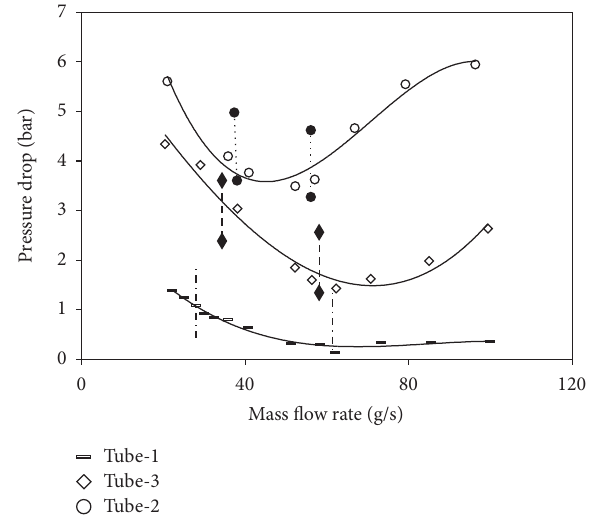
F 8: e comparison of the oscillation boundaries for all